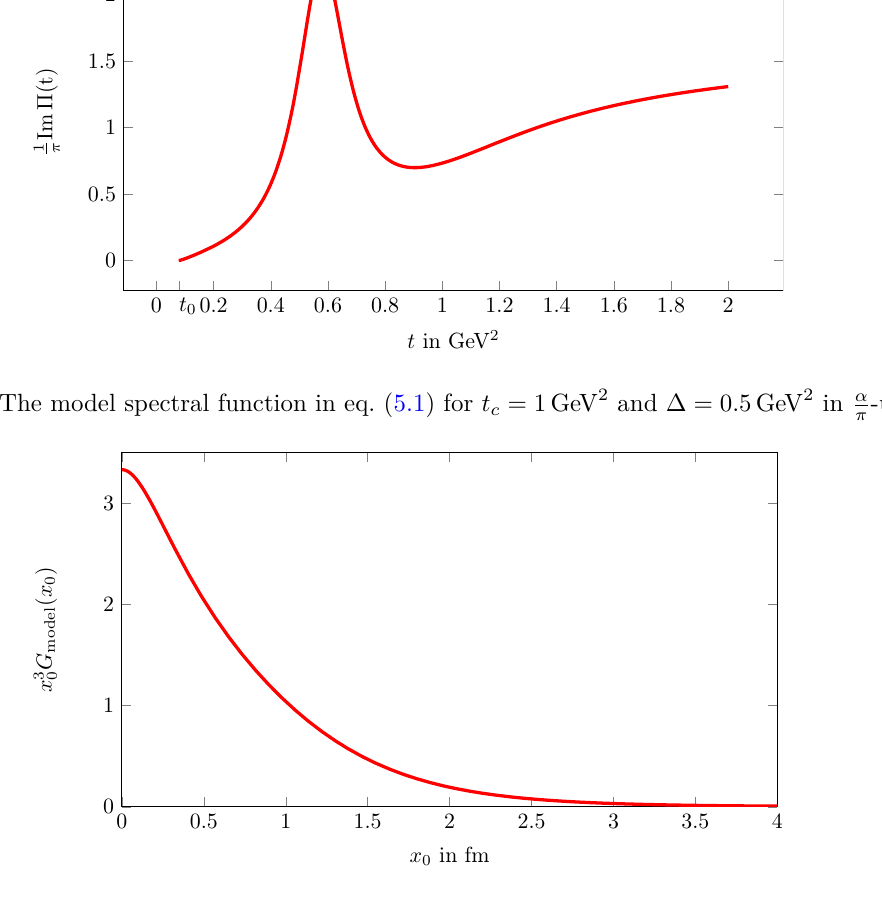
Figure 5 . The model TMR function x 3